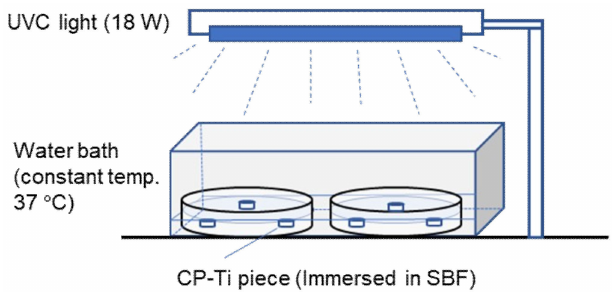
Figure 1. Schematic drawing of apparatus for immersion tests of CP-Ti with UV light irradiation.